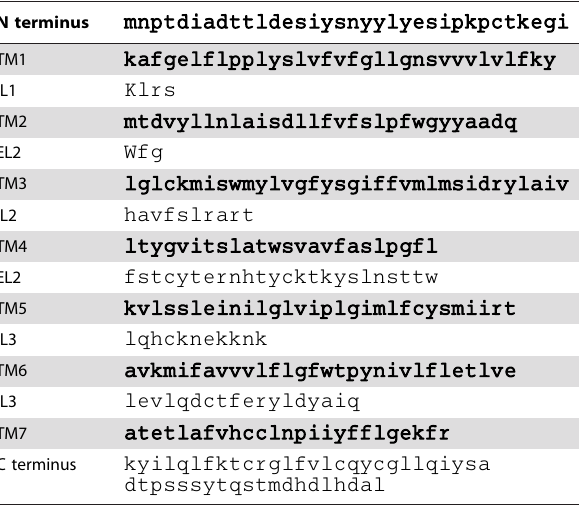
Table 1. The predicted transmembrane (TM), intracellular loop (IL) and extracellular loop (EL) regions of the human CCR4